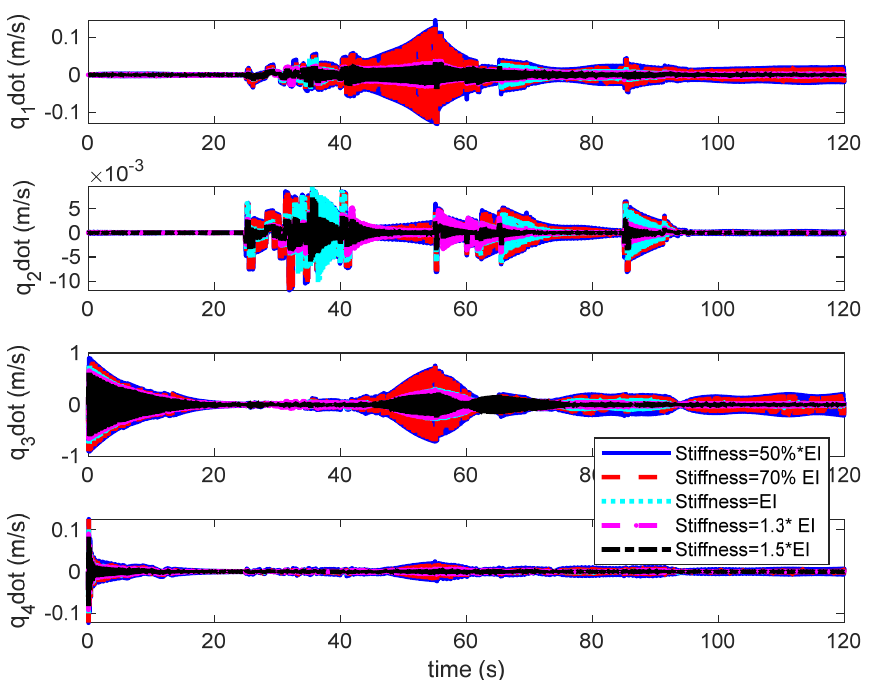
Figure 15. The generalized coordinate velocity responses of structure modes.